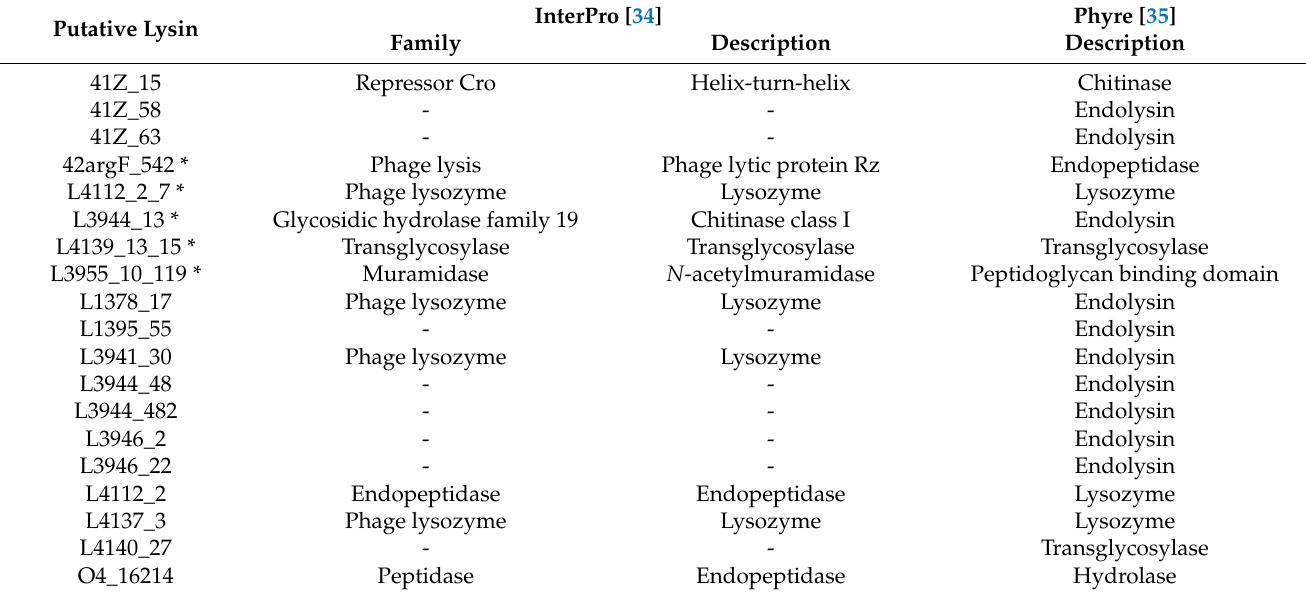
Table 2. Functional analysis of putative lysins inferred by protein sequence and predicted structure.